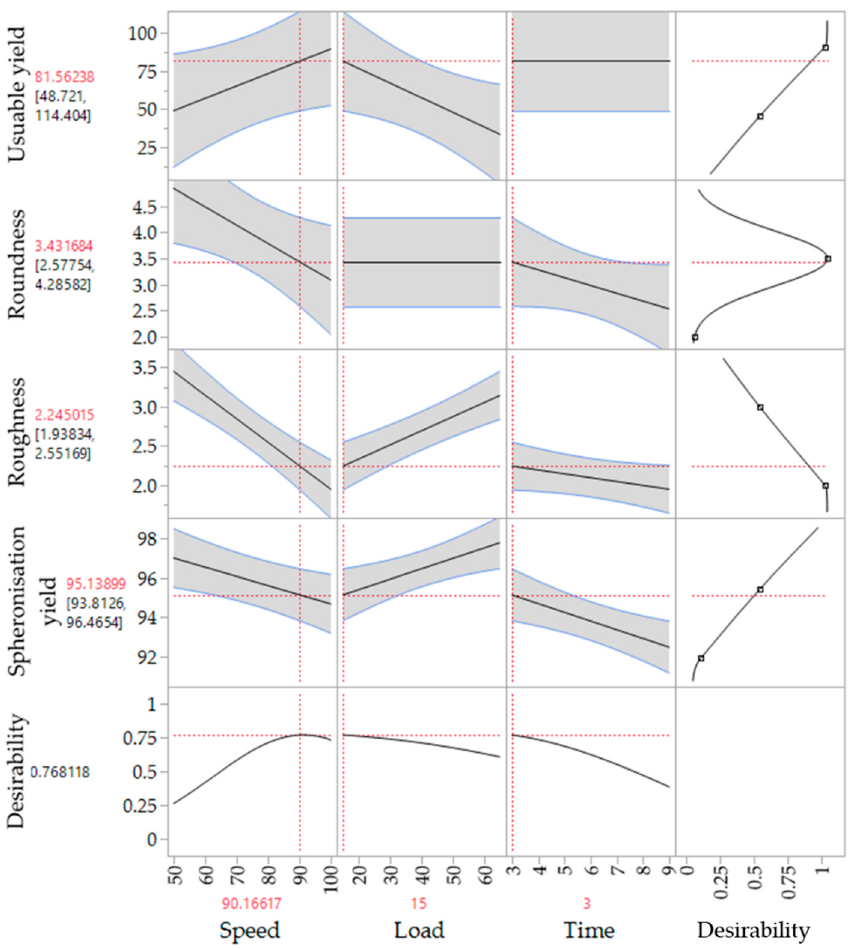
Figure 10. Proposed spheronisation configurations for a maximized desirability of all responses.